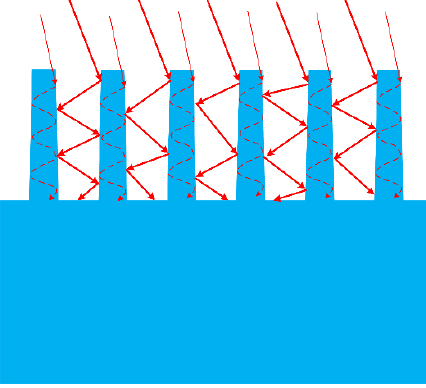
Figure 8. Schematic diagram of two light trapping mechanisms of scattering and total internal reflection in the light trapping of NPAS (not to scale).